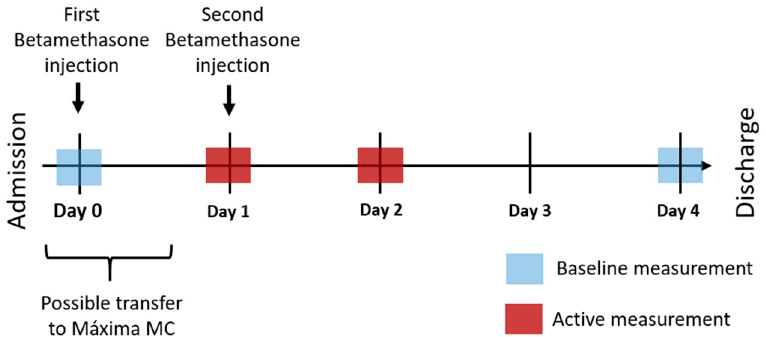
Figure 2. Baseline and active measurements epochs acquired in the primary phase of the study. The baseline measurements epochs are defined on day 0 and/or day 4 (light blue), while active measurements epochs are defined on day 1 and day 2 (dark red).